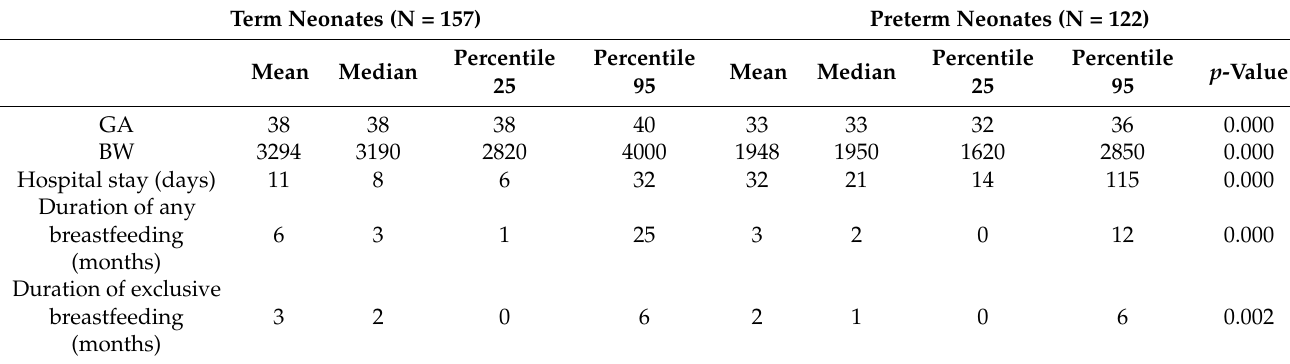
Table 2. Clinical characteristics of preterm and full-term study